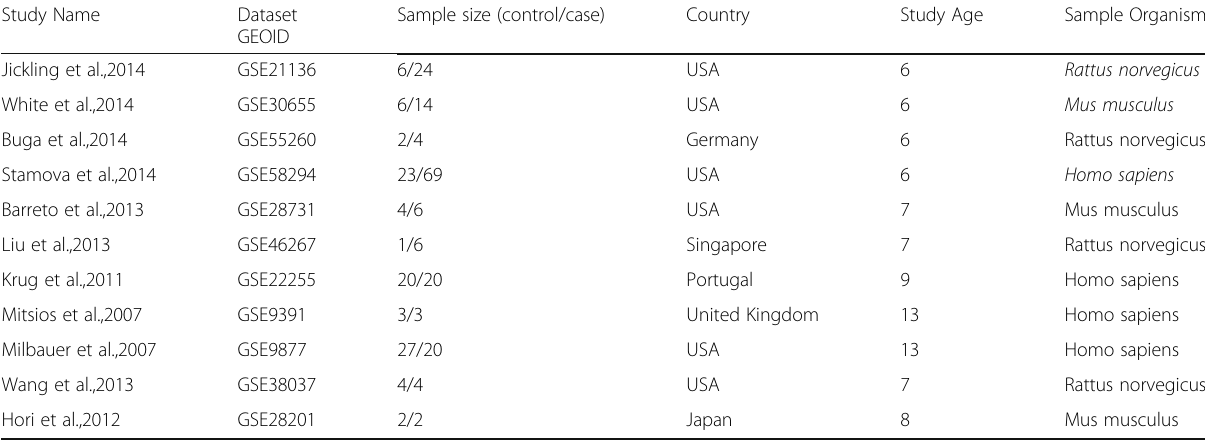
Table 1 Datasets selection for mega-analysis